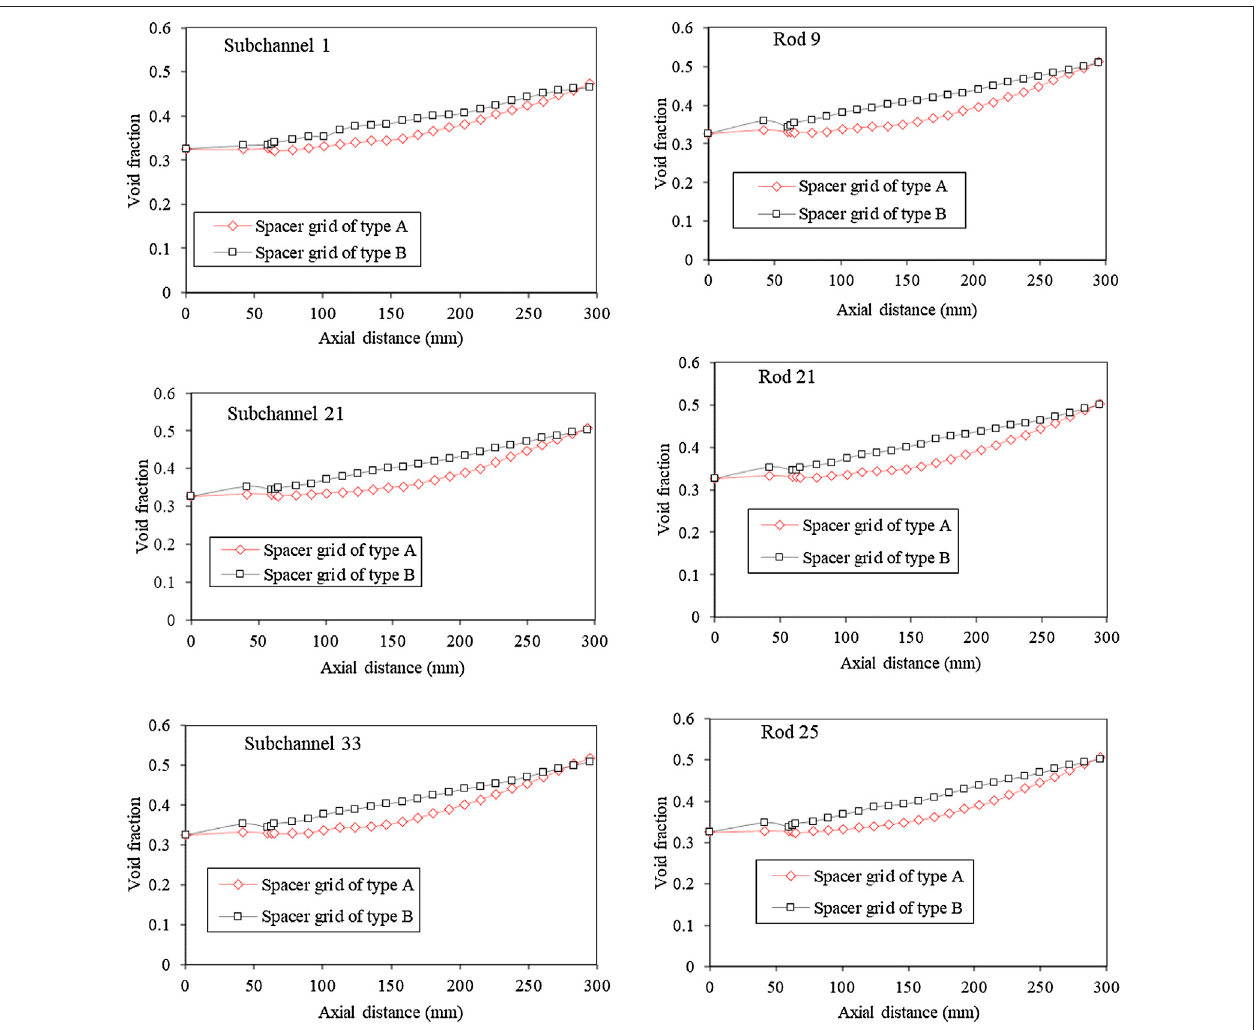
FIGURE 13 | Average void fraction of cross sections in the sub-channel and around the fuel rod along axial direction for different spacer grids.